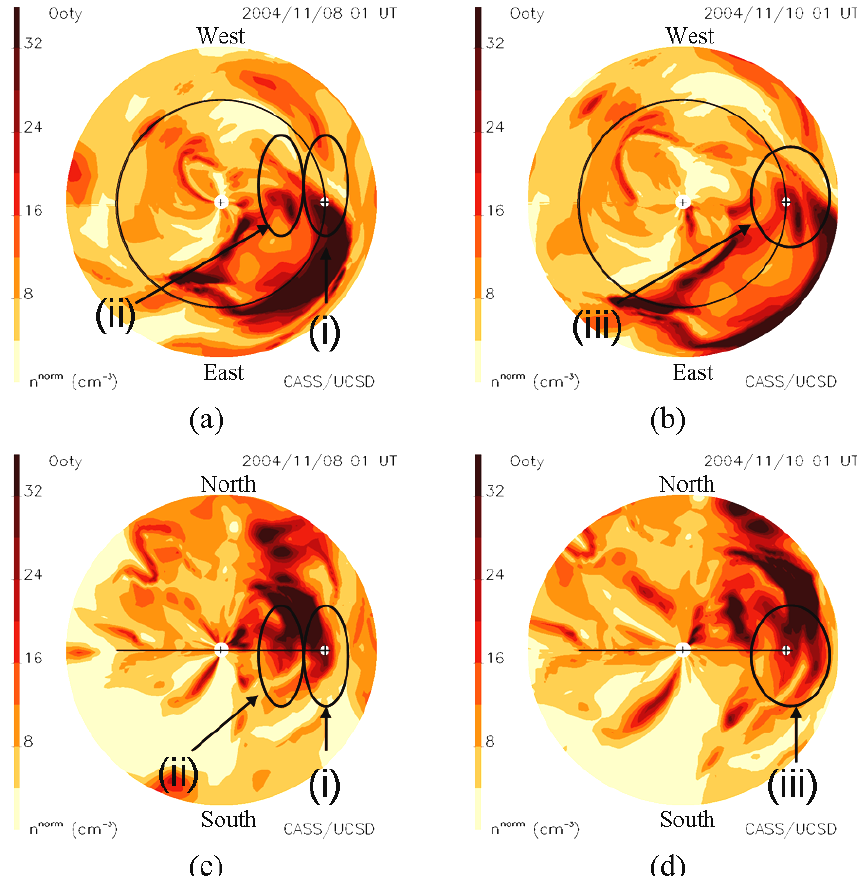
Fig. 4. As with Fig. 3 but for density. The expected r − 2 density fall-off scaling is used to normalize structures at different radii. Density contours to the left of each image are scaled to